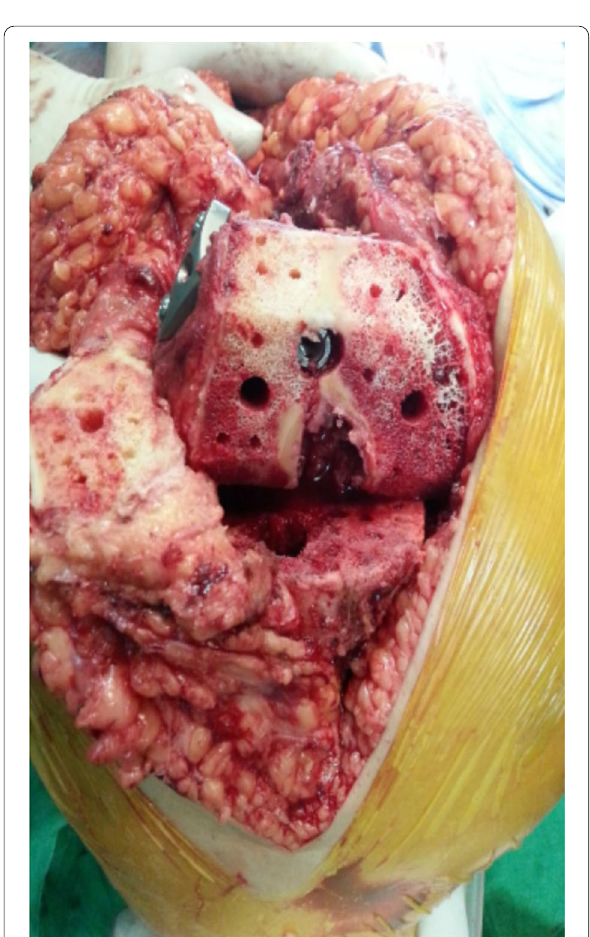
Fig. 2 The bone cuts with RIMN (SIGN nail) and locking